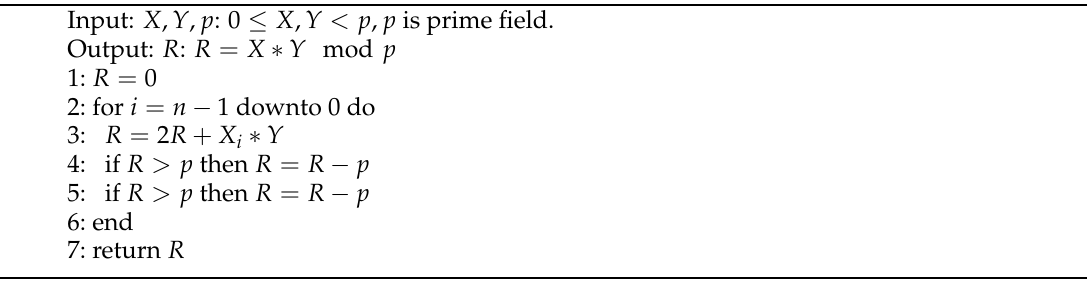
Algorithm 3: Standard Interleaved Modular Multiplication Algorithm